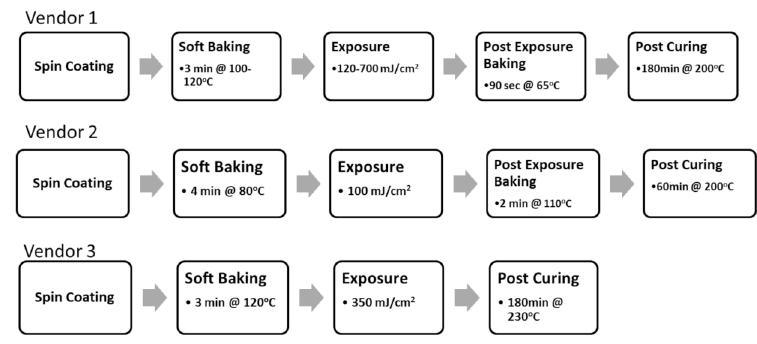
Figure 2. Sample preparation procedure for the measurement.